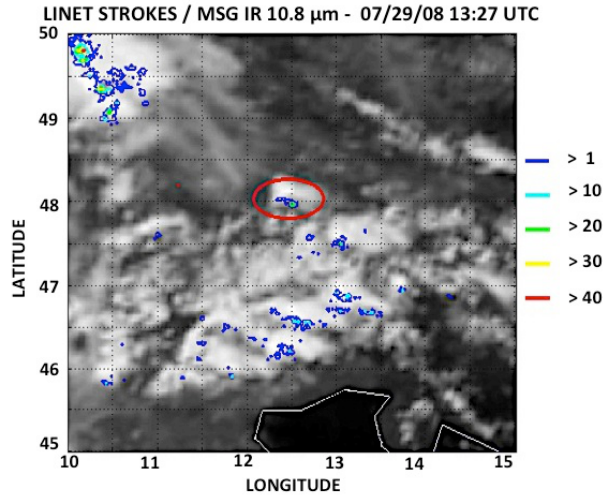
Fig. 5. IR 10.8µm MSG image of a central Europe region at 13:27UTC, 29 July 2008, with superimposed contours of light- ning activity as detected by the LINET network during the previous 15min. The different colors show the accumulated stroke density over a grid at 2 × 2km 2 horizontal resolution. The red circle identi- fies the location of the analyzed thunderstorm cell of Case 1.